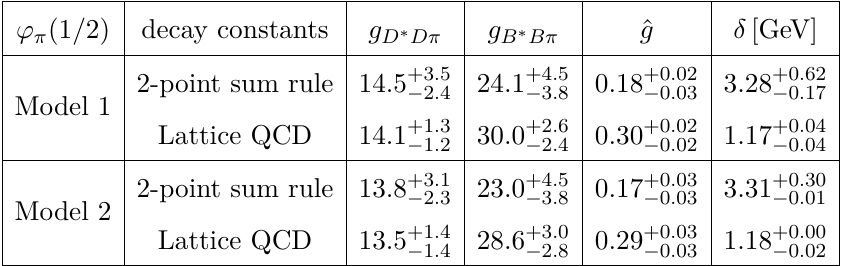
Table 6 . LCSR results for the strong couplings of the charmed and bottom mesons for the two methods of dividing out the decay constants and the two models of the pion twist-2 DA, at the central values of